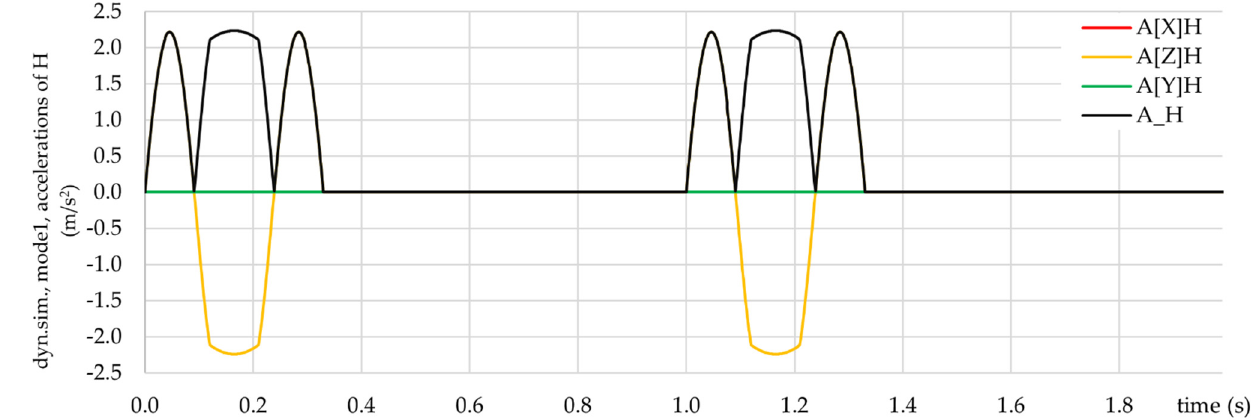
Figure 5. Computed results in Mode 1 in terms of accelerations of H